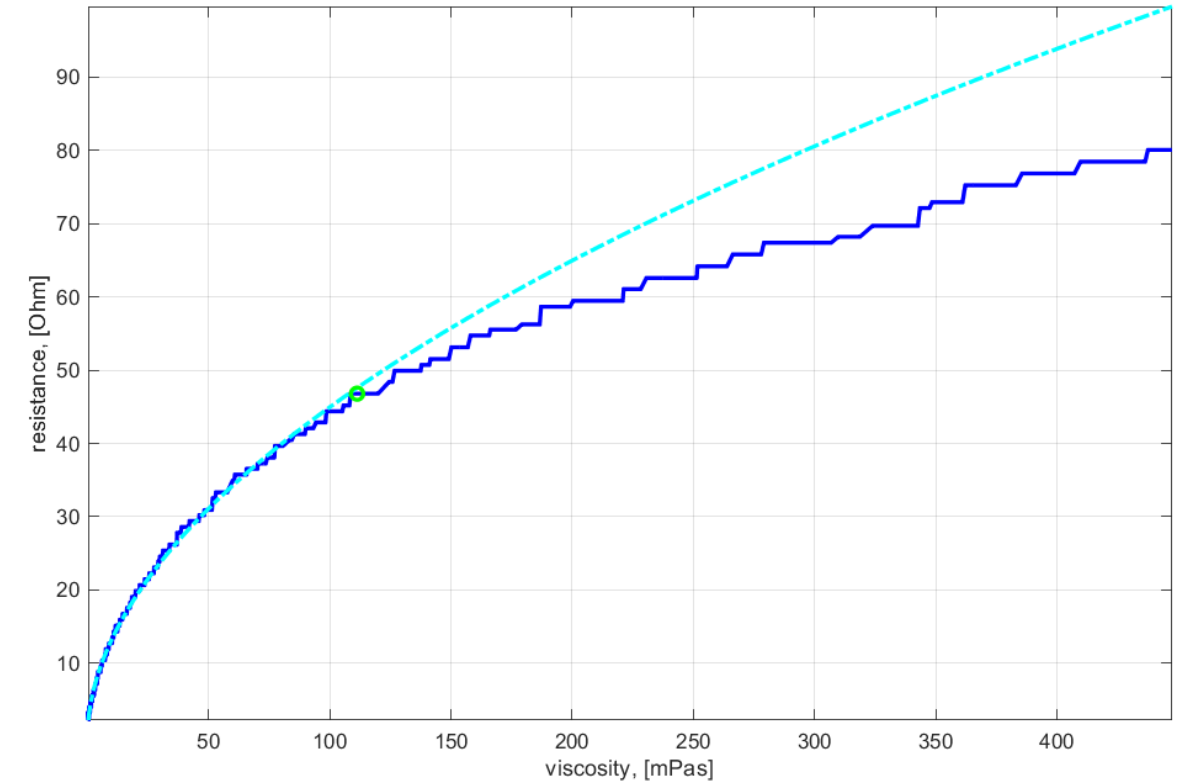
Figure 5. Correlation of electric resistance data with thermoset resin viscosity (dark blue), together with the model curve (light blue) corresponding to the point of maximum ‘goodness-of-fit’.